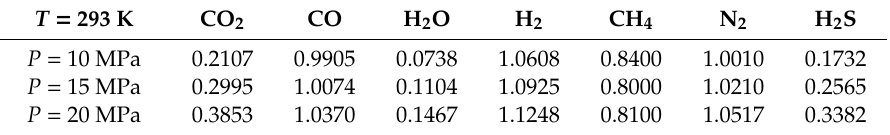
Table 4. The compressibility values of the mono-component gases for the selected pressure. T = 293 K CO 2